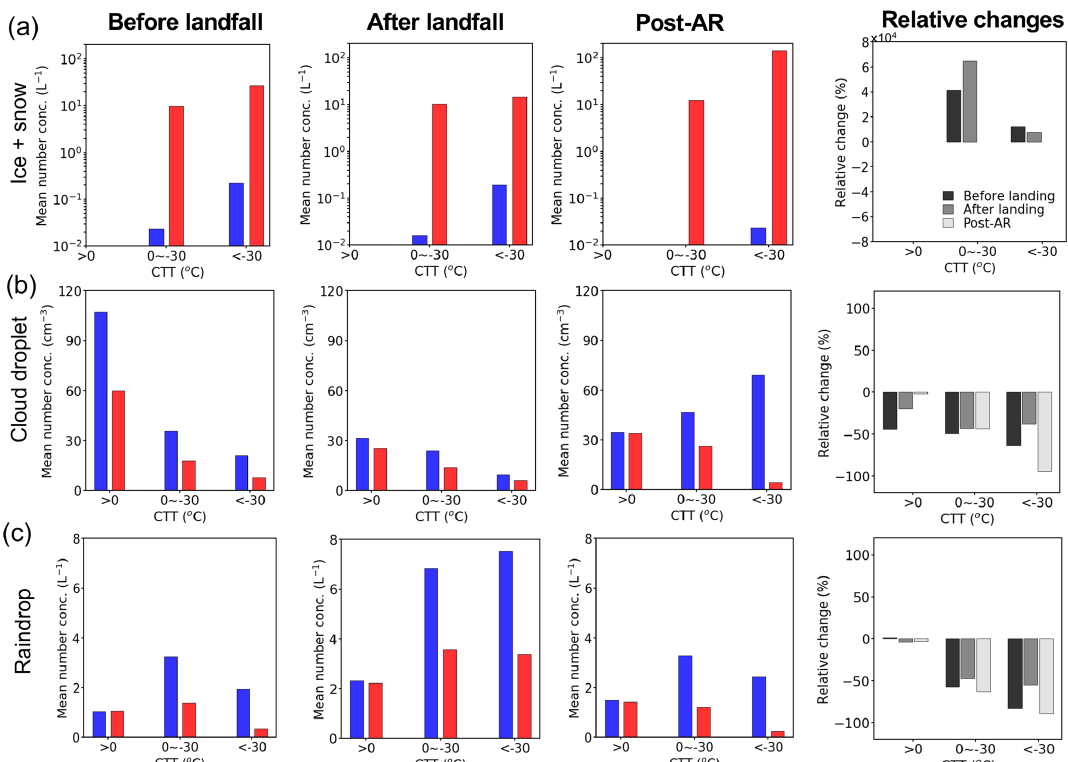
Figure 12. Hydrometeor number concentrations and their relative changes in three cloud regimes in DM15 (blue) and DM15 + MC18 (red) at the three AR stages for (a) ice particles (sum of ice and snow), (b) cloud droplets, and (c) raindrops. The last column shows the relative changes caused by the marine INP effect, which are calculated as [(DM15 + MC18)–DM15] / DM15 × 100%. Since ice particles are very limited at the post-AR stage in DM15, the percentage changes of ice particles from DM15 to DM15 + MC18 are huge numbers that are omitted from the